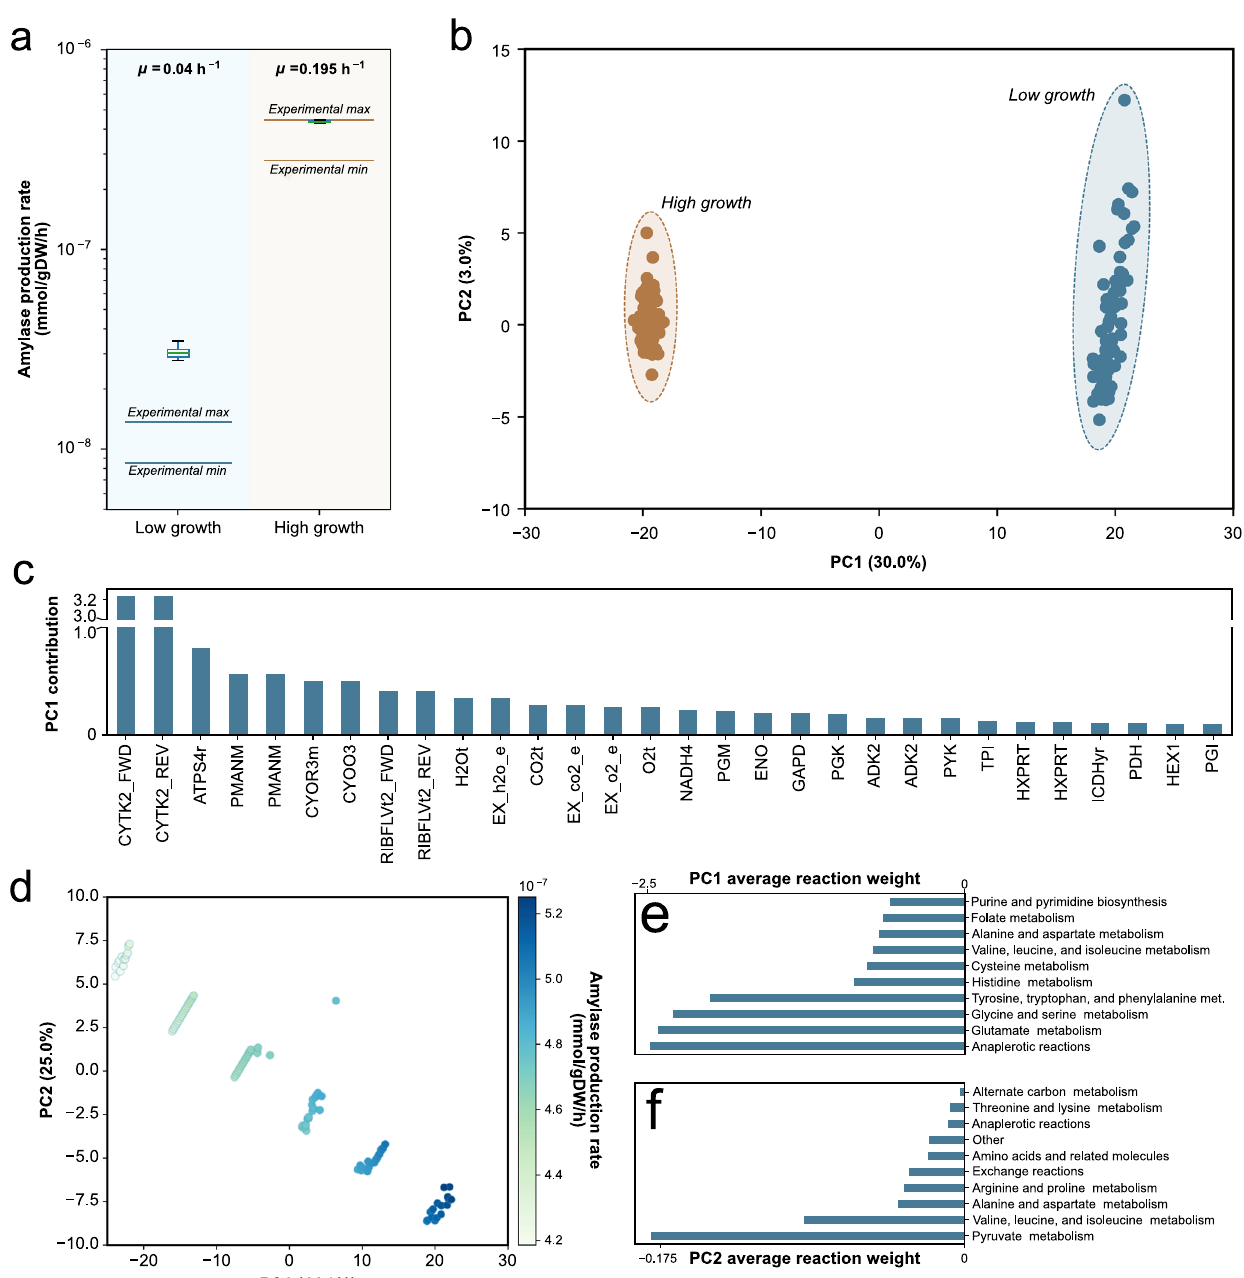
Fig. 4 Prediction of amylase secretion. a Prediction of amylase secretion rate at two different growth rates. The distribution of amylase production rates was calculated by sampling the solution space close to the optimal growth rate (see “ Methods ” ). Low growth data was taken from ref. 31 , at a growth rate of 0.04 h − 1 . High growth data was taken from ref. 32 , at a growth rate of 0.195 h − 1 . The molar amylase production rate was calculated from reported activity data (see “ Methods ” ) and presented in log scale on the y axis, b PCA plot of the sampling with the fi rst two components in low and high growth conditions. c Average reaction contributions to the difference of PC1 position of samples. d Sampling of the overexpression of amylase at high growth (see “ Methods ” ). The samples are color-coded with their respective amylase secretion rate with units of mmolgDW (cid:1) 1 h (cid:1) 1 . e , f The bar plots show the average reaction weight of subsystems in the two principal components, PC1 ( e ) and PC2 ( f ), that describe the highest variance in the sampling of amylase